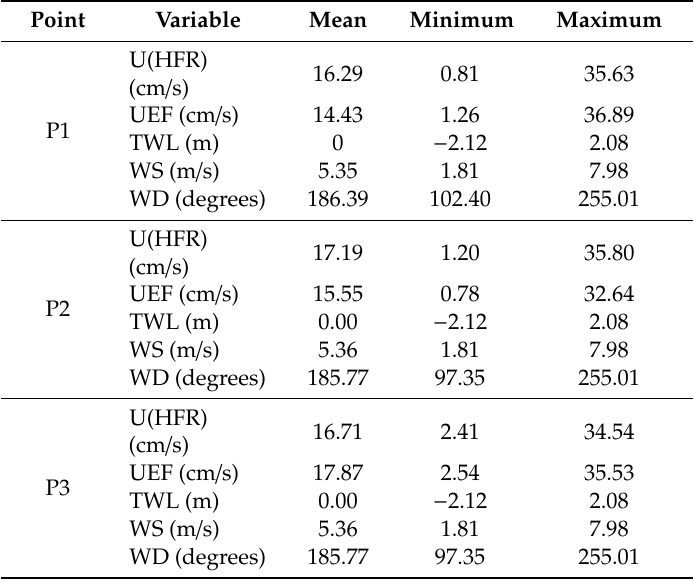
Table 1. Mean and range of training dataset (60% of total dataset).